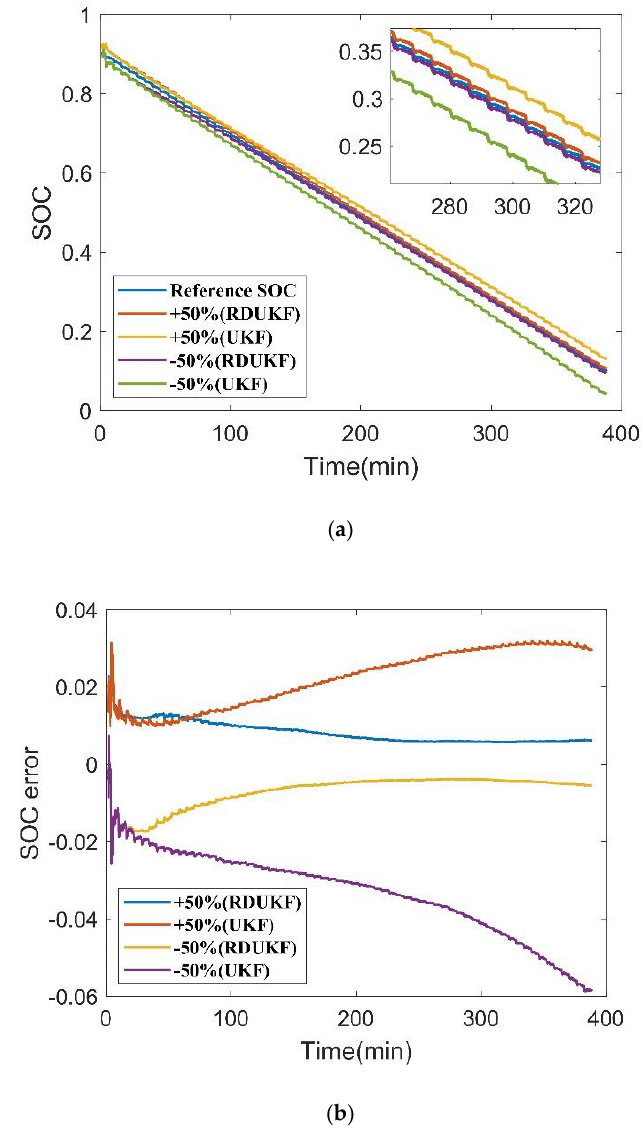
Figure 8. ( a ) SOC estimation results according to deviations in R0; ( b ) SOC error according to deviations in R0.